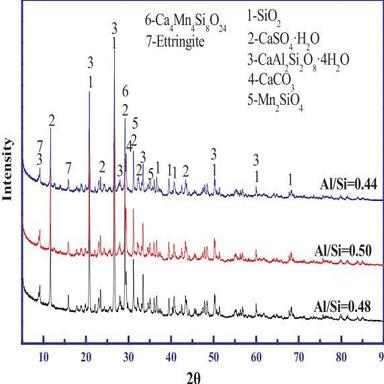
XRD patterns of the pastes with different Al/Si ratios hydrated at 7 d.